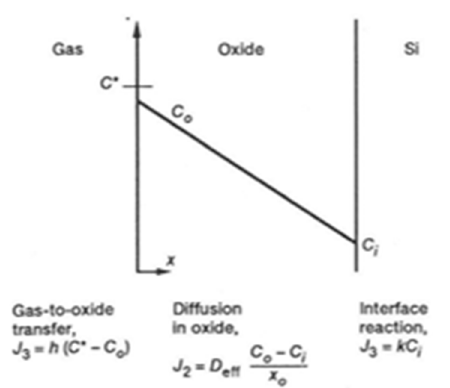
Figure 5. Model for the oxidation of silicon at the two boundaries of the oxide layer. Reprinted with permission from Reference [11]. Copyright 1965 AIP.